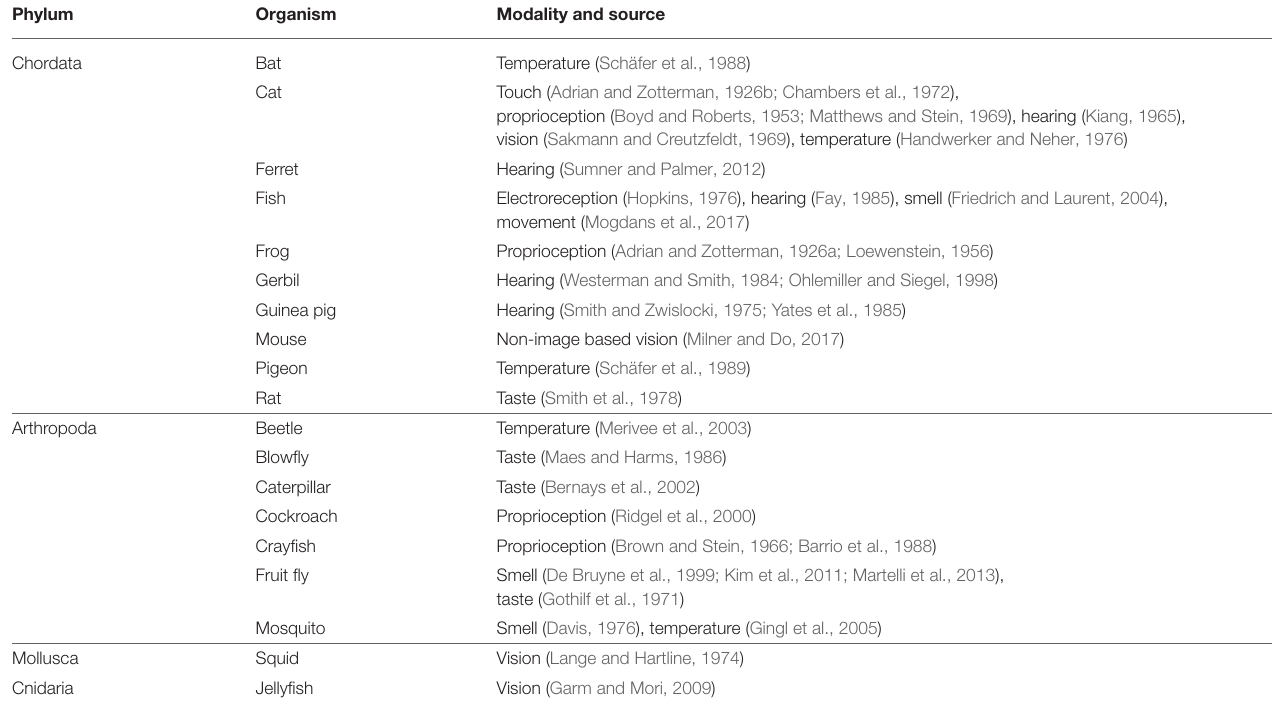
TABLE 2 | Summary of studies analyzed organized by animal